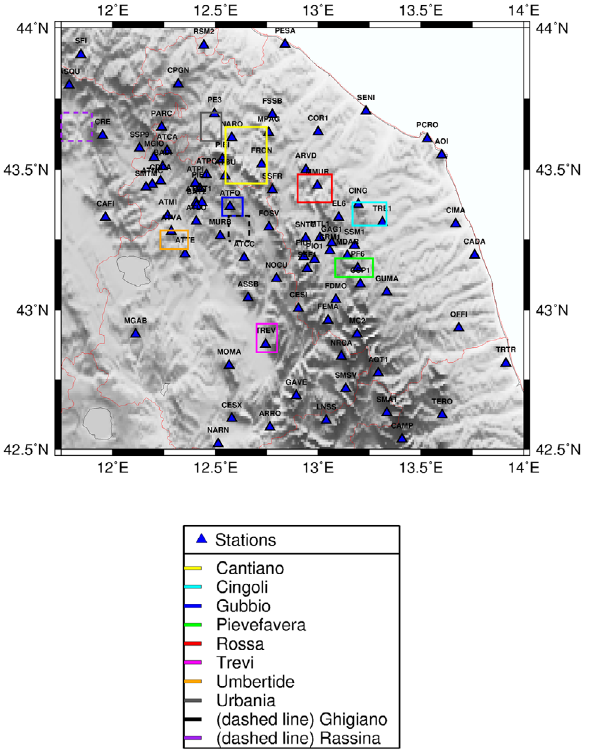
Figure 1. Map of the stations used in this paper, and of the recog- nized source areas of non-tectonic events. Solid lines: quarry areas. Dashed lines: other non-tectonic sources.